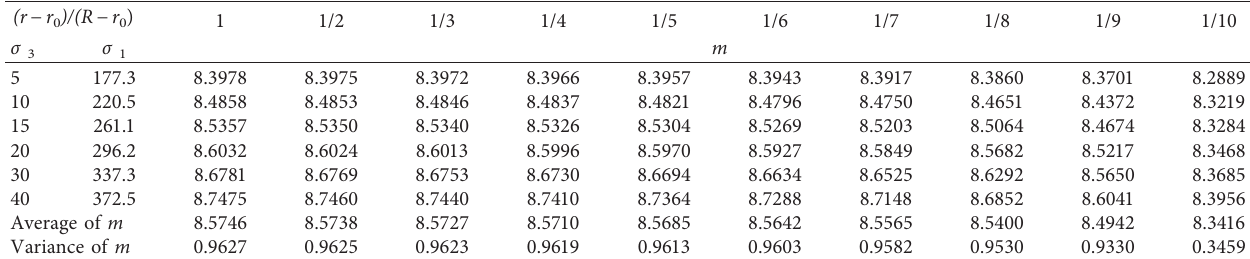
Table 3: The value of m in the specimen with an aperture of 10mm.